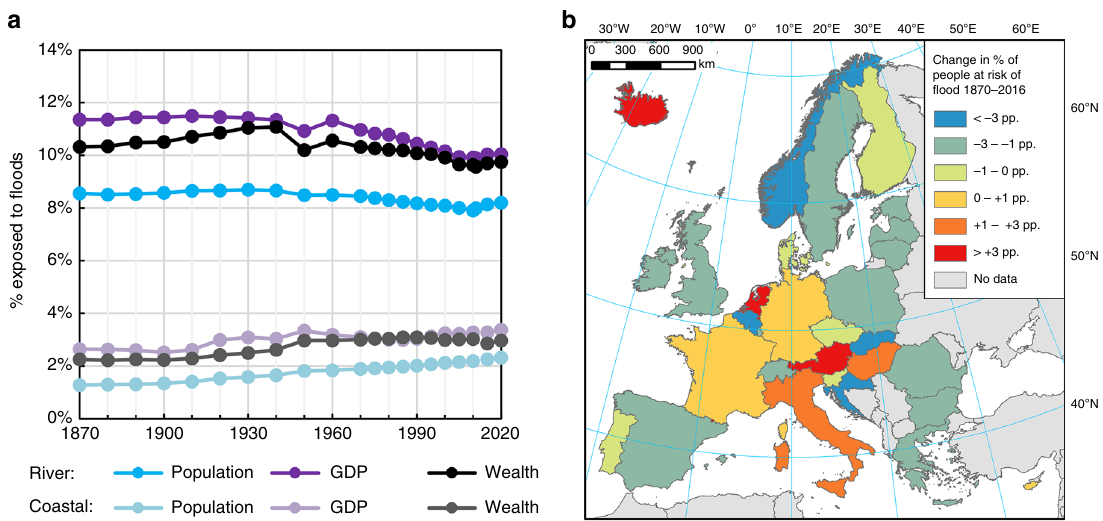
Fig. 1 Trends in fl ood exposure. Percent of the population exposed to the 100-year river and coastal fl ood in Europe ( a ), including short-term projection to year 2020, and change in population exposed ( b ), in percentage points, to the 100-year fl ood (either river or coastal) in each country (1870 – 2016). Source of data: HANZE database 47 with country borders from PBL